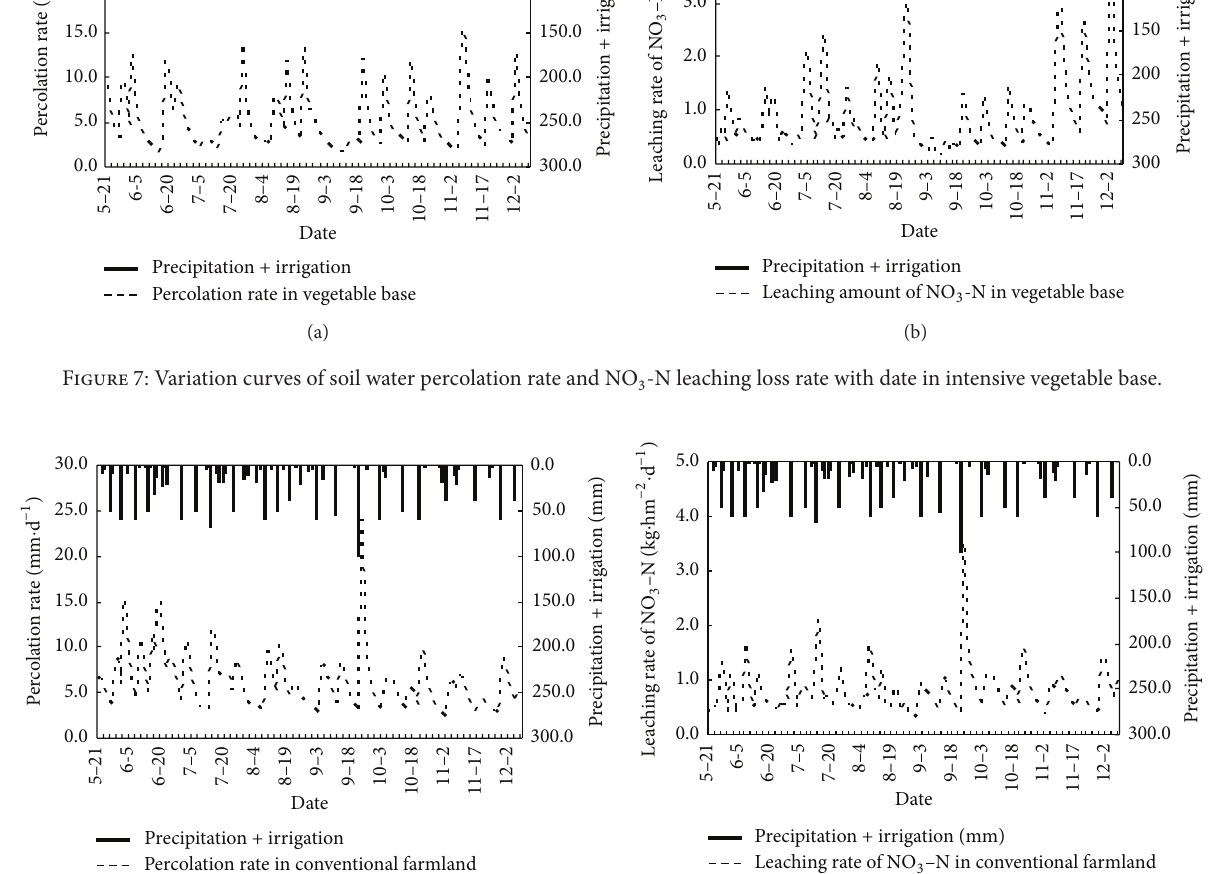
Figure 8: Variation curves of soil water percolation rate and NO 3 -N leaching loss rate with date in conventional